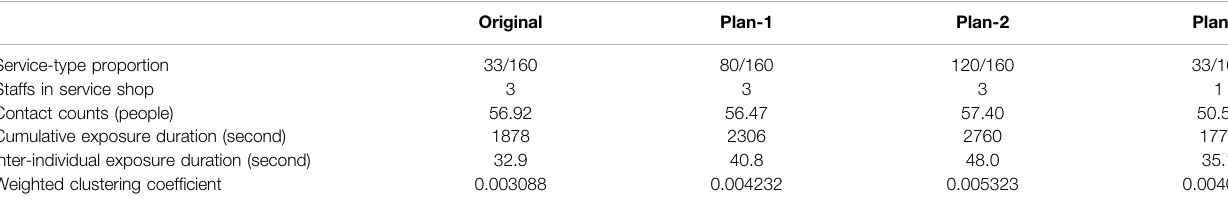
TABLE 4 | Estimation results of individual contact indicators in different adjustment